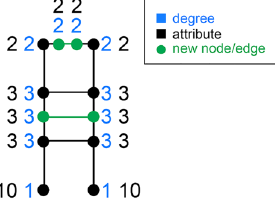
Figure 2. Adding nodes in a specific way preserves the Singular Generalized Friendship Paradox gap sign and increases the degree-attribute correlation to the limit of 1. This figure is an example of a first step of this process, with new nodes and edges in